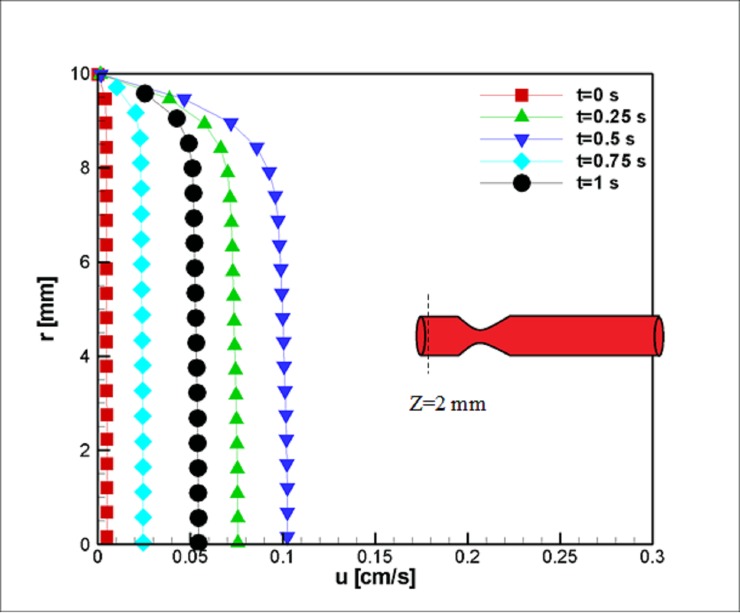
Velocity profile in the axial direction near the inlet at z = 2 mm for the case without Joule heating, Lvessel = 7 cm, Rvessel = 1 cm and fifty percent stenosis.